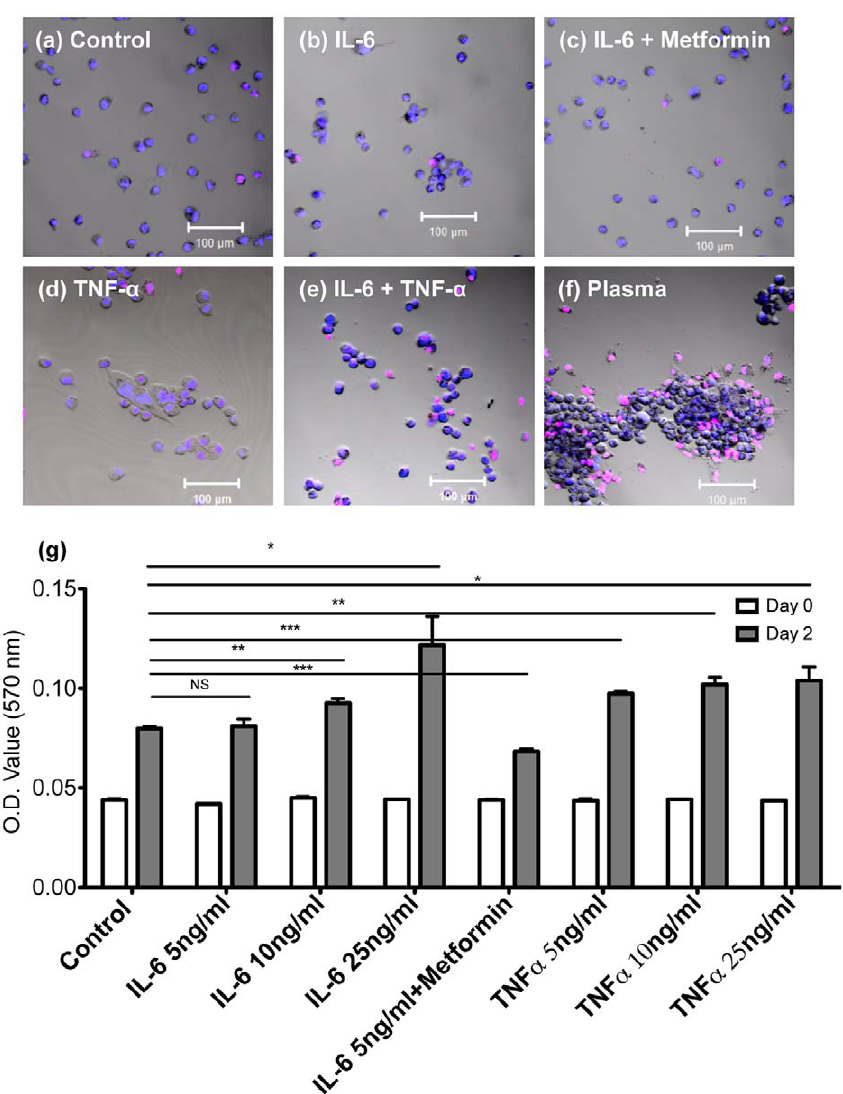
Figure 3. Plasma, IL-6, and TNF- a promote breast cancer cell growth as aggregates. Morphology and viability of MDA-MB-231 cells cultured in (a) regular medium, (b) IL-6 (5 ng/mL) spiked medium, (c) IL-6 (5 ng/mL) and 0.1 mmol Metformin added medium, (d) TNF- a (5 ng/mL) spiked medium, (e) IL-6 and TNF- a (5 ng/mL each) spiked medium, and (f) healthy donor plasma. A blue fluorescent cell-permeable nucleic acid dye (for live cell staining) and a red fluorescent cell-impermeable nucleic dye (for dead cell staining) were used to visualize the live and dead populations. (g) Cell proliferation results via MTT assay of control media, IL-6, TNF- a , and Metformin treated MDA-MB-231 cells.